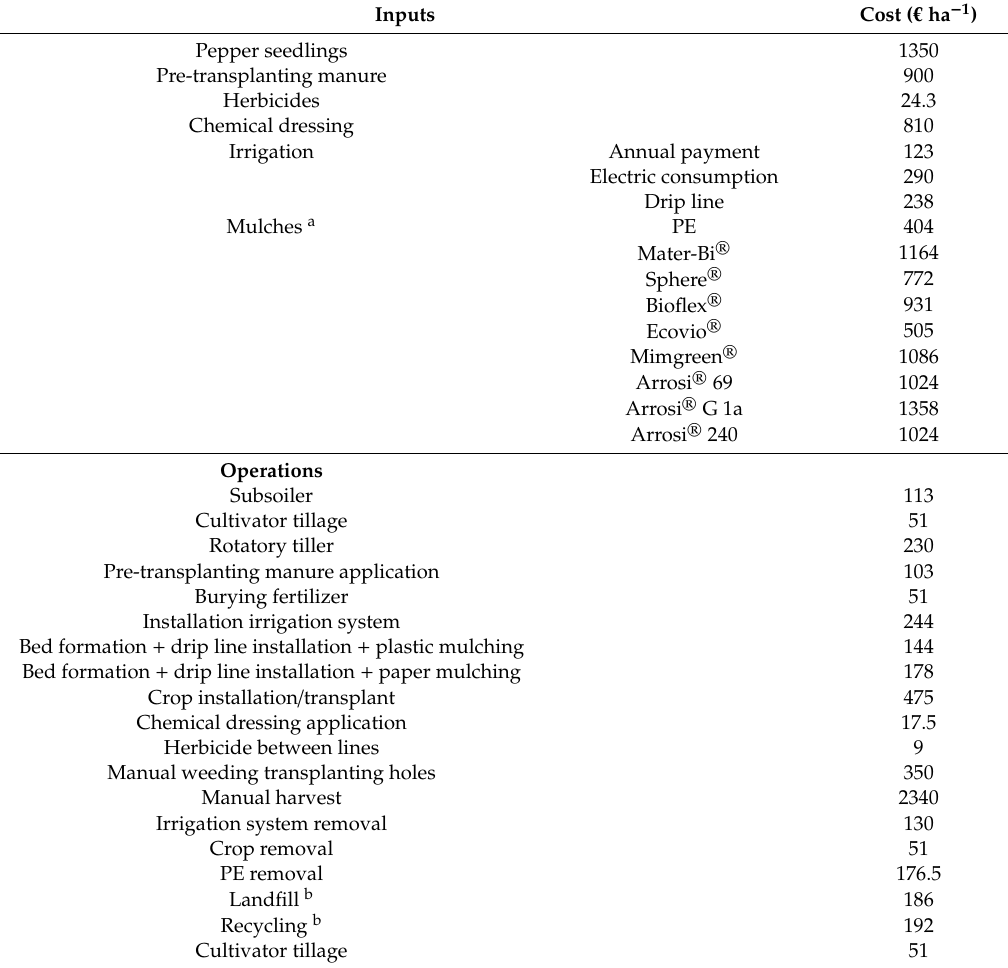
Table 3. Costs ( € ha − 1 ) of inputs and operations in open-air pepper